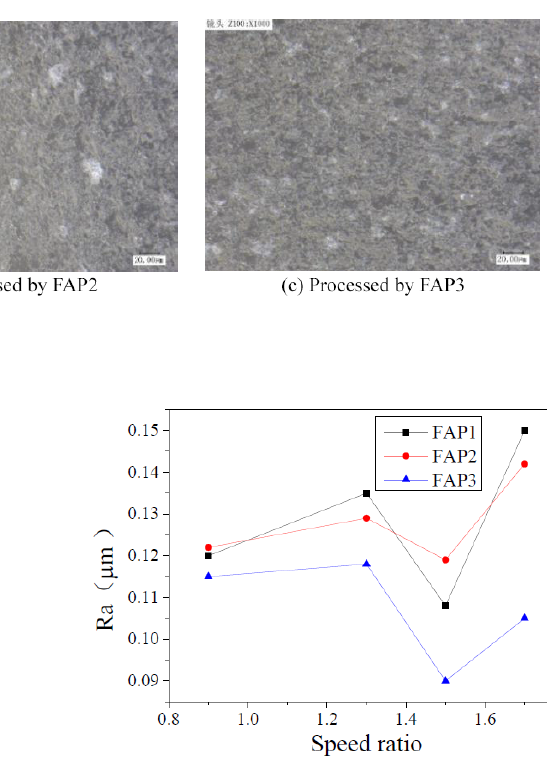
Figure 14. Surface roughness vs. speed